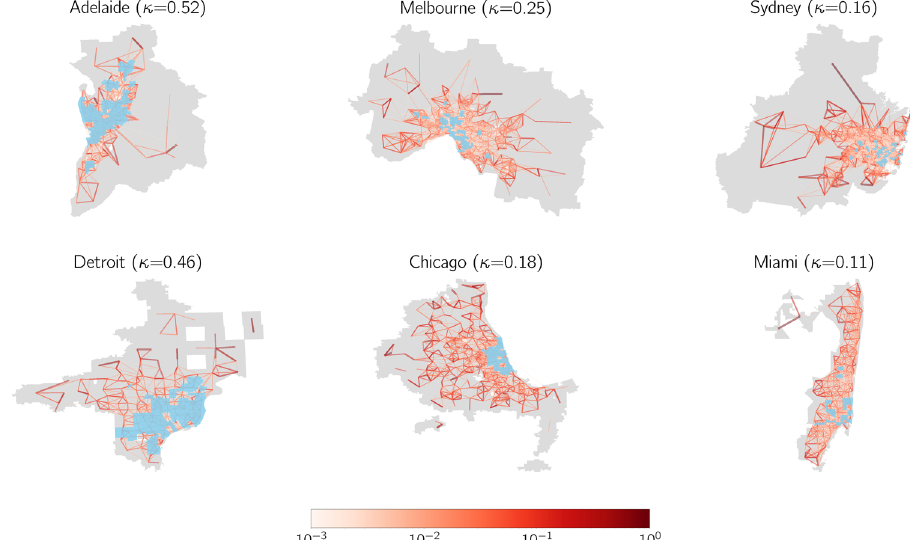
Fig. 1 Spatial representation of the urban mobility network for selected cities in Australia and the United States. Areas marked blue correspond to population density hotspots. The cities are organized in descending order according to the extent to which mobility fl ows are concentrated between areas of high population density, κ (Eq. (1)). Line color encodes the number of inhabitants following each route normalized by the highest fl ow observed within each